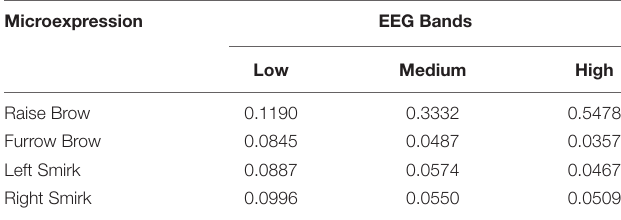
TABLE 6 | Normalized population